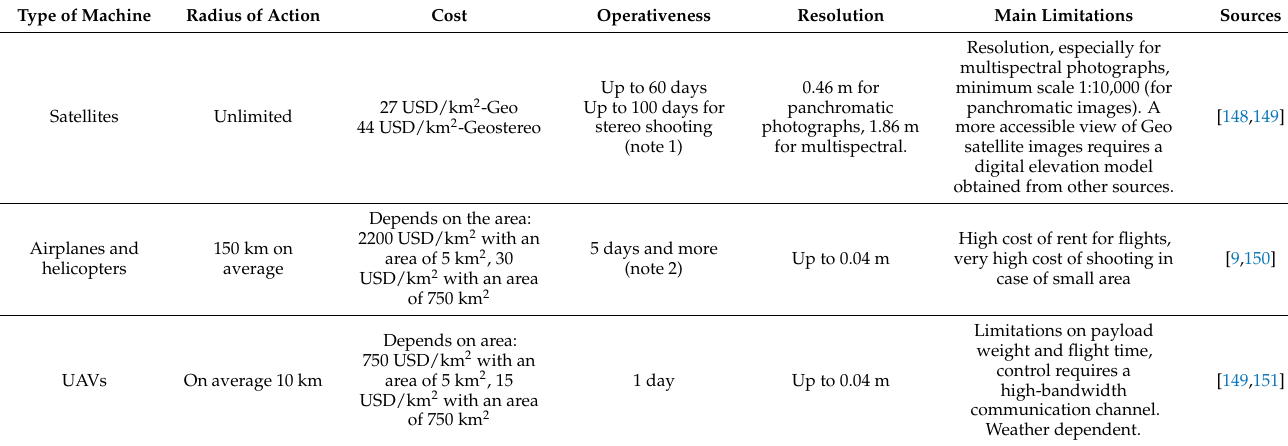
Table A1. Applications of spatially distributed data acquisition systems.